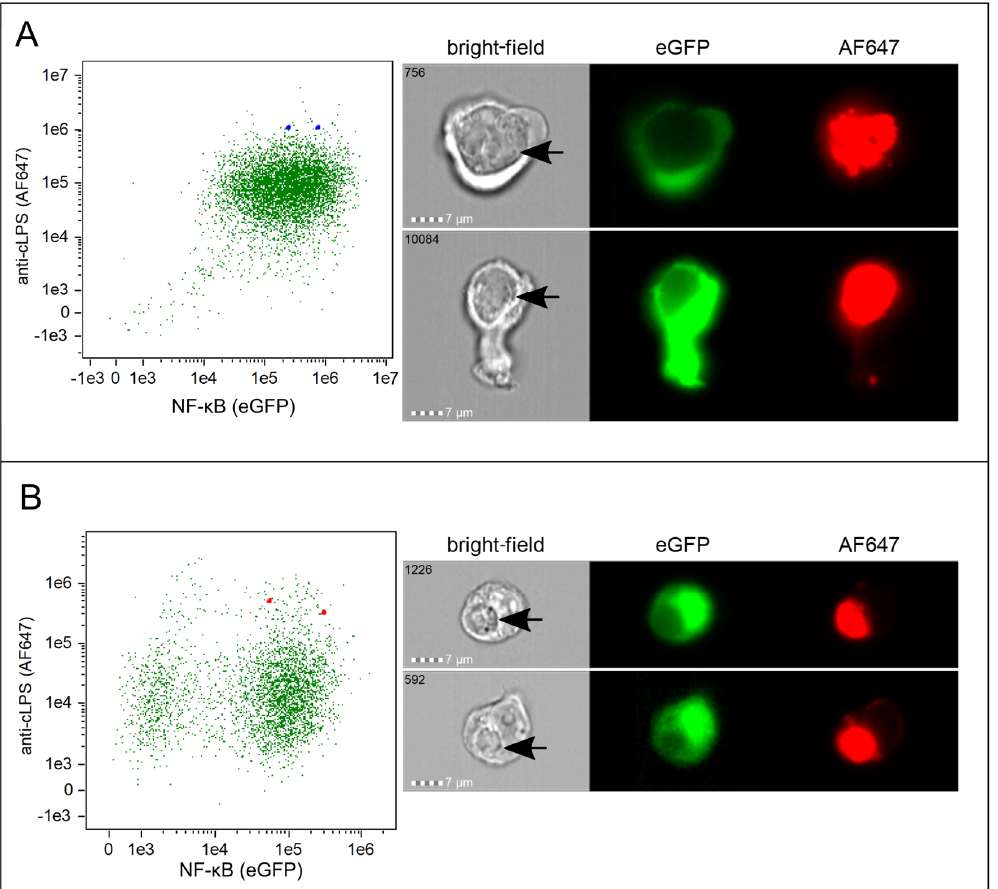
Figure 5. Imaging flow analysis of Ct incubated reporter cells. Representative dot plots including the corresponding imaging flow cytometry profiles of individual ( A ) THP-1 TLR4/CD14/MD2 reporter cells (blue squares) and ( B ) Jurkat TLR4/CD14/MD2 reporter cells (red squares) 40 h after inoculation with viable Ct serovar E (MOI 10). NF- κ B signaling was measured by eGFP expression (x-axis) and uptake by intracellular staining with AF647-labelled anti- c LPS mAb (y-axis). The two selected cells indicated in the dot plots by the squares are shown in the bright-field, AF647 and eGFP channel. Inclusions are marked with black arrows in the bright-field. The sequence number of each individual cell recorded is indicated in the bright-field image.